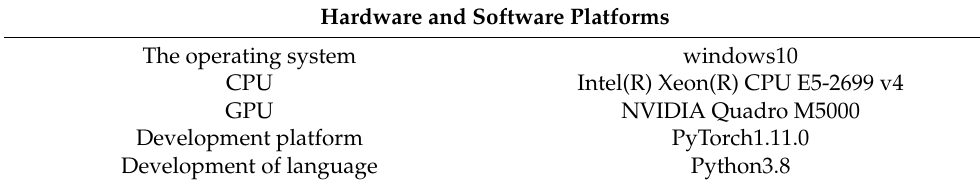
Table 3. Hardware and software